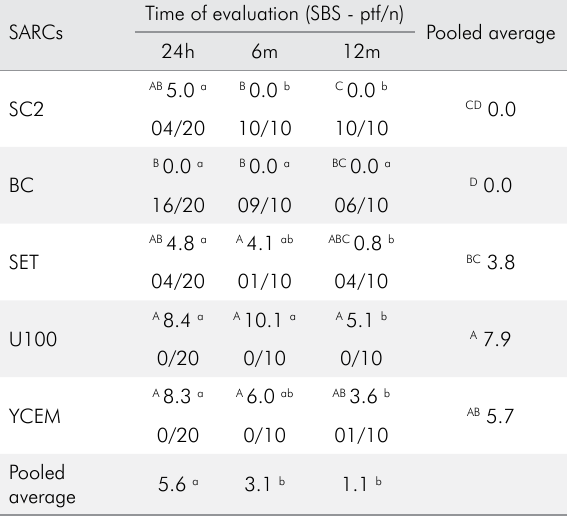
Table 2. Shear bond strength (SBS) median values in MPa and the number of pre-testing failures/total number of tested specimens